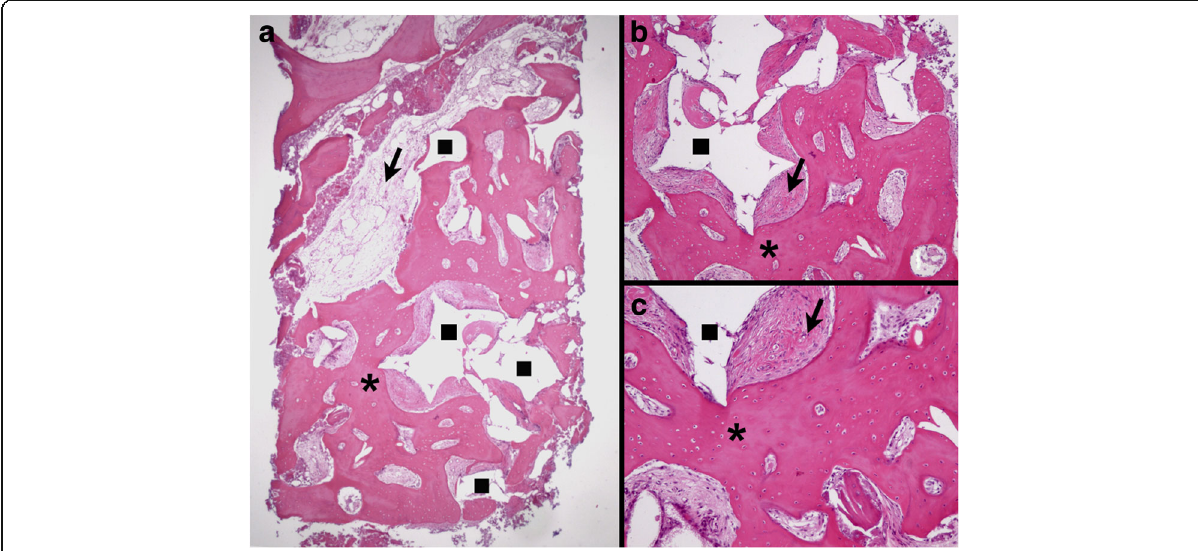
Fig. 3 Histomicrograph of a biopsy from the BC+EMD group. Overview — ×25 magnification; b ×30 magnification; c ×60 magnification. Areas corresponding to BC+EMD removed during histological processing ( square ) surrounded by newly formed bone ( asterisk ), with large numbers of osteocytes and soft tissue ( arrow ) can be observed. There is direct contact between the BC reminiscent, soft tissues, and vital bone (hematoxylin-eosin